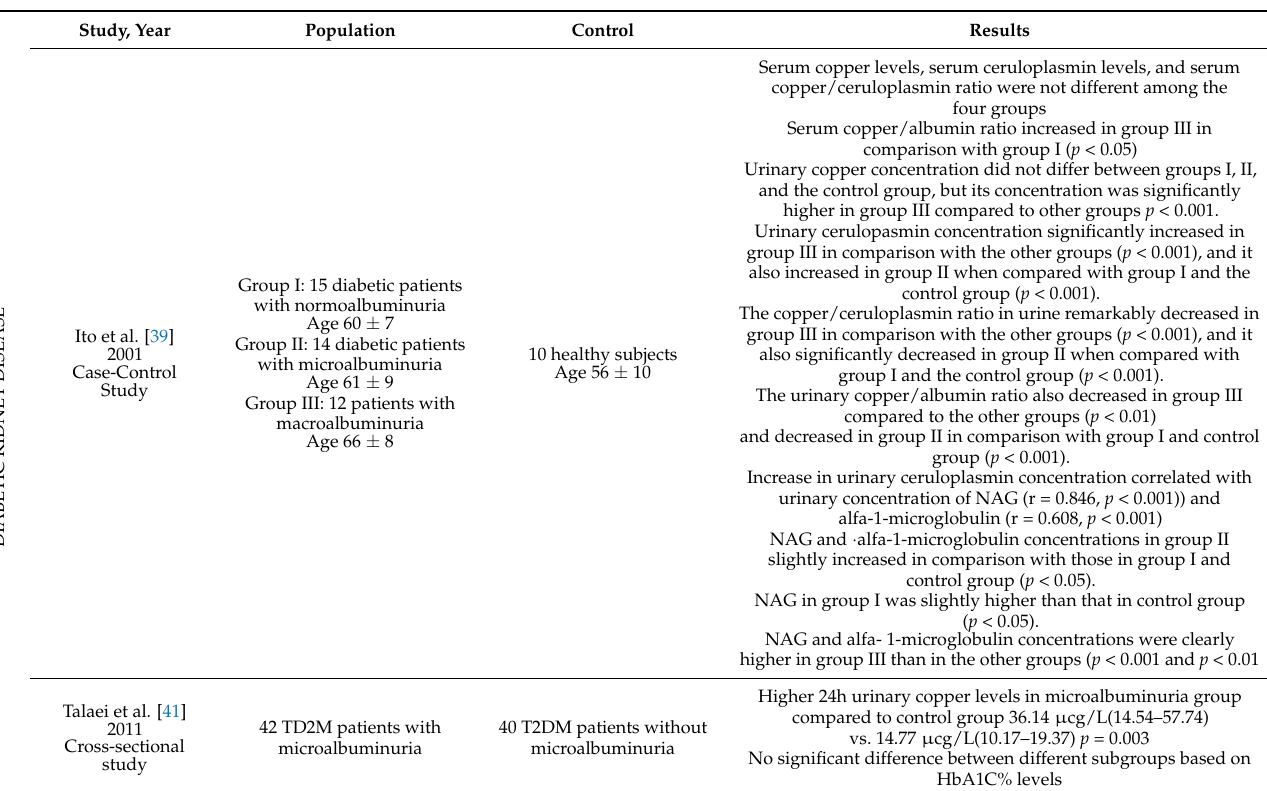
Table 5. Copper in Diabetic Kidney Disease. Cu, Copper. SOD, Superoxide Dismutase. T2DM, Type 2 Diabetes Mellitus. Zn,